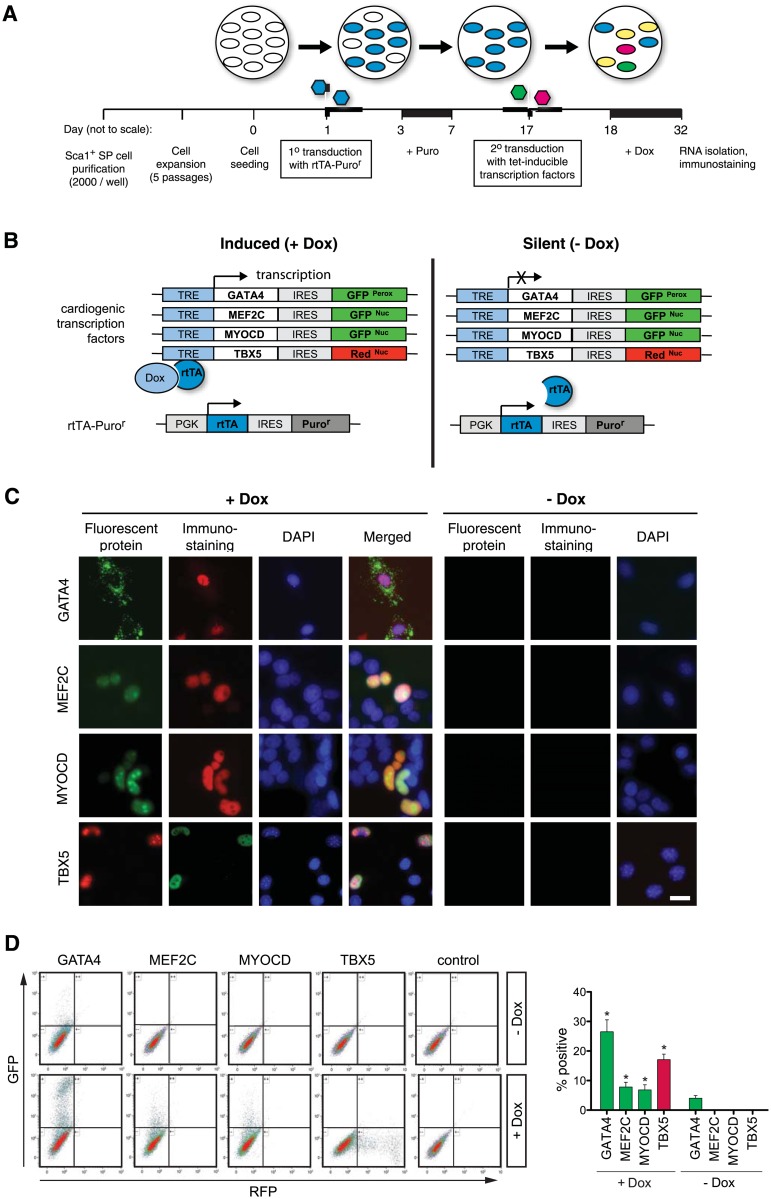
Dox-dependent expression of exogenous transcription factors in adult mouse CSCs.A: Timeline for the cardiogenic differentiation assays. CSCs were seeded in 6-well dishes (day 0), transduced with the rtTA-PuroR lentiviral vector (day 1), and subjected to selection of successfully transduced cells in Puro (days 3–17). The selected transduced CSCs were re-seeded, transduced with Dox-inducible vectors for co-expression of transcription factors plus fluorescent reporters (day 18), and treated with Dox to induce the respective ectopic proteins (days 19–33). CSCs were then processed for RNA isolation and immunocytochemistry. B: Schematic representaiton of the induced (+Dox) and silent (-Dox) state. The system involves paired lentiviral vectors, rtTA-PuroR constitutively expressing the reverse Tet transactivator (rtTA) and a Puromycin resistance gene (PuroR), and a Dox-inducible series encoding the respective cardiac transcription factors and targeted reporter proteins via a Tet-responsive element (TRE). Co-expression in these bicistronic vectors is mediated by an internal ribosome entry site (IRES). C: Immunocytochemistry showing Dox-dependent expression of the ectopic transcription factors in transfected 293FT cells, which lack the corresponding endogenous factors, and appropriate intracellular targeting of all the respective reporters. D, E: Flow cytometry showing Induction of the transcription factor-reporter cassettes in transduced CSCs (MOI = 100). D: Representative dot plots. E: The percentage of fluorescent protein-expressing CSCs is shown as the mean ± SD for three samples, and is representative of additional experiments using one or more of the indicated factors. *, p < 0.05 for the presence or absence of Dox.